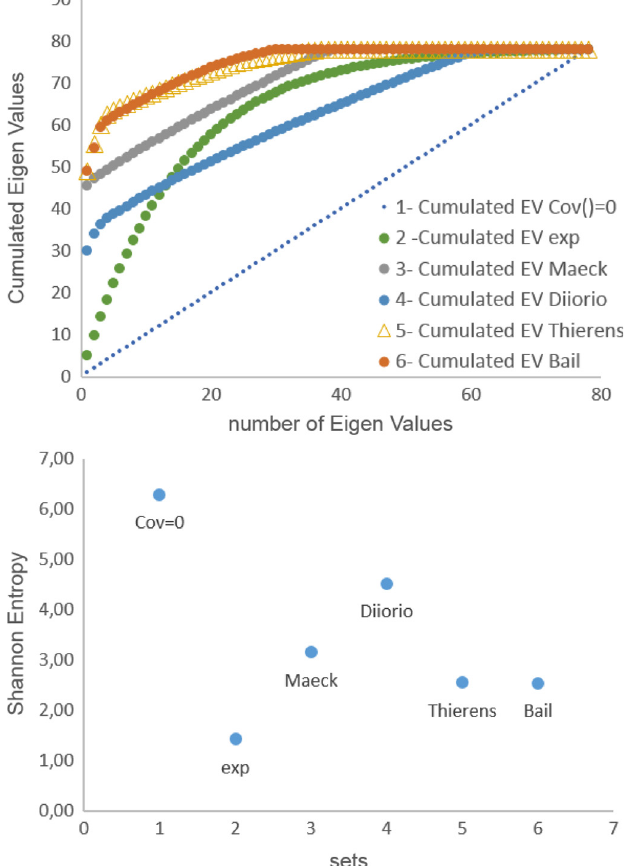
Fig. 7. (Up) for each correlation matrix of evaluations, cumulated eigenvalues (EV) are plotted as a function of the number of EV. For instance, we represent also the cumulated EV for null covariance terms and for an exponential distribu- tion of EV. (Down) Shannon entropies as a function of the data set number with respect to the index in the previous legend.